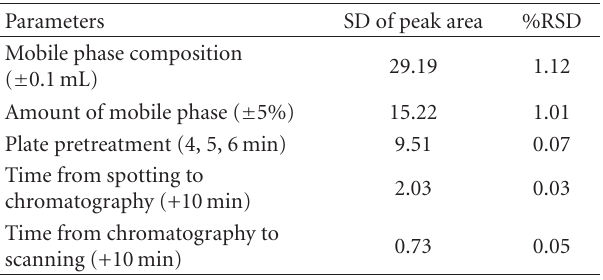
Table 2: Robustness testing a .